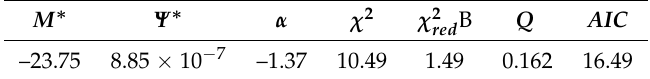
Table 2. Parameters of the Schechter LF in the range [ 0.3,0.5 ] when k = 3 and n =